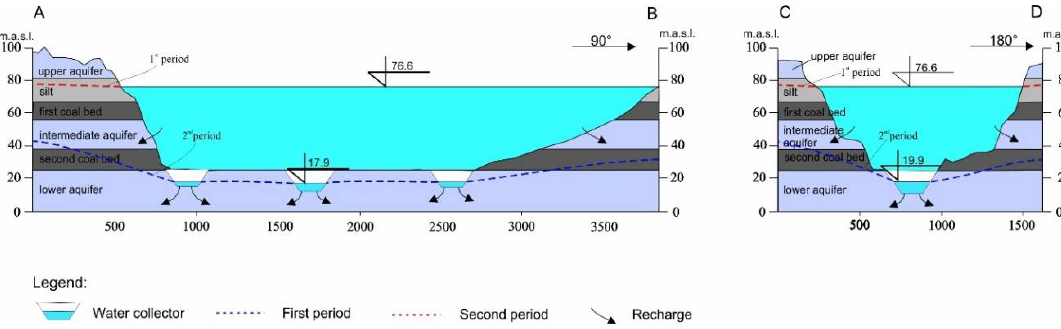
Figure 7. Two typical sections of the flood lake at Tamnava West-Field.